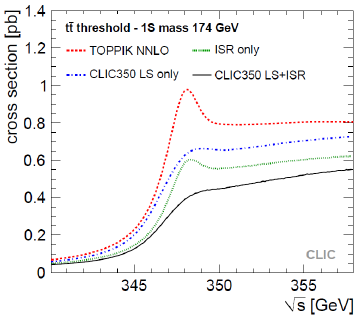
Figure 7. Top pair production cross-section from theory calculations, with the luminosity spectrum (LS) of CLIC at 350 GeV and initial state radiation (ISR) e ff ects included